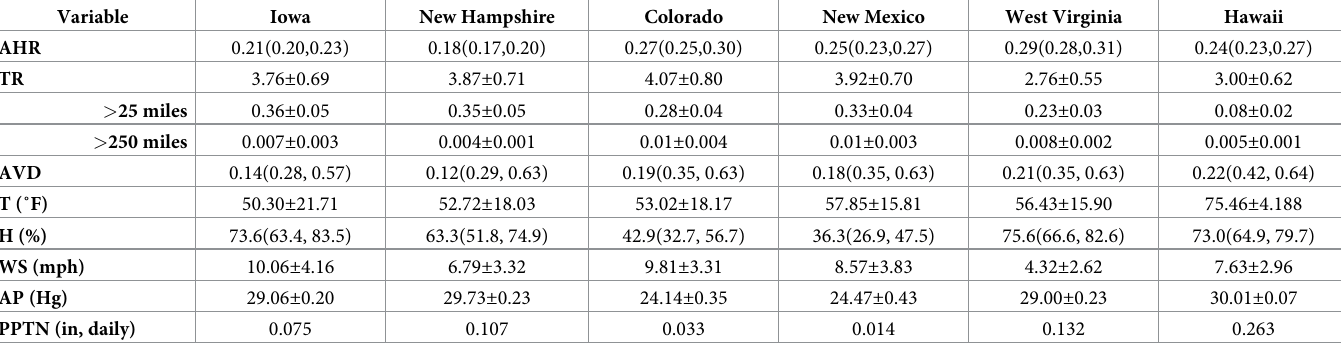
Table 1. The basic information of 6 representative states [X ± SD/M (P 25 , P 75 )].